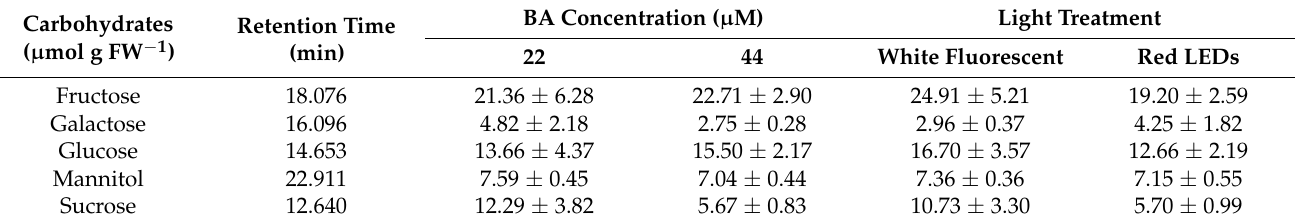
Table 1. Effect of 6-benzyladenine (BA) concentration (22 and 44 µ M) and light treatment (white fluorescent or red LEDs) on carbohydrate content of Pinus radiata D. Don shoots cultured in rooting medium (Quoirin and Lepoivre (LP) medium [27], modified according to Aitken-Christie et al. [28], supplemented with a mixture of 5 µ M 1-Naphthaleneacetic acid (NAA) and 10 µ M indole-3-butyric acid